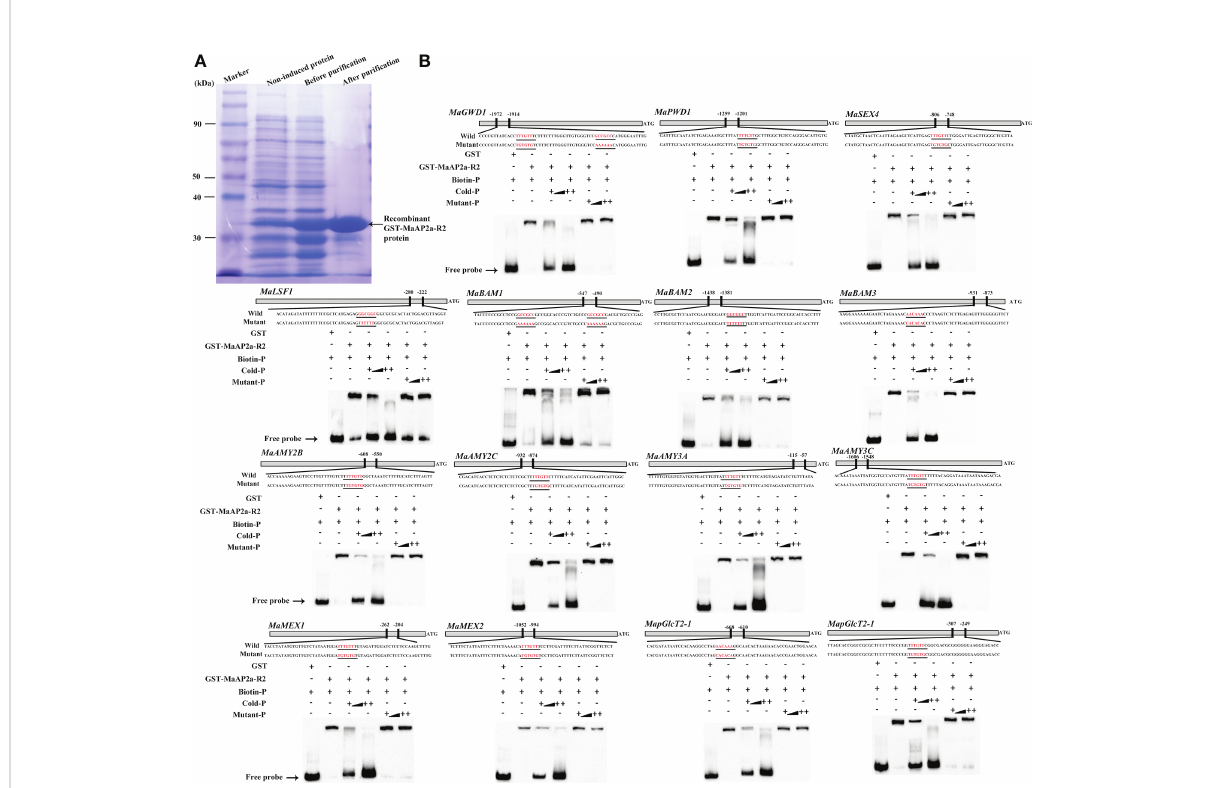
FIGURE 5 MaAP2a binds to the promoters of starch degradation-related genes in vitro . (A) Af fi nity puri fi cation of the recombinant GST-MaAP2a-R2 protein and SDS-PAGE gel dyed with Coomassie brilliant blue shows that the recombinant protein is suitable for the EMSA. (B) EMSA showing MaAP2a binding to the promoters of starch degradation-related genes containing GCC-box or AT-rich element. The probe sequences corresponding to each of the target gene promoters are shown, with red letters representing the GCC-box or AT-rich and their mutant. The puri fi ed GST or recombinant GST-MaAP2a-R2 protein was mixed with probes, and the protein – probe complexes were separated on native polyacrylamide gels. Triangles indicate increasing amounts of unlabeled or mutated probes for